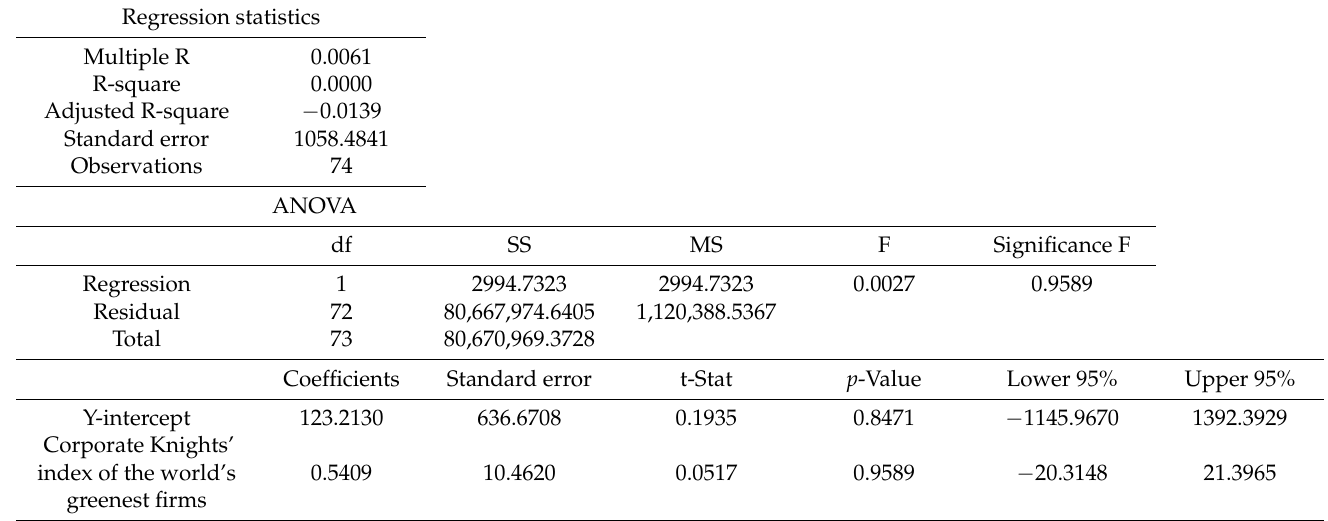
Table 4. Regression analysis of the dependence of the risk of profit reduction on the level of corporate social responsibility in